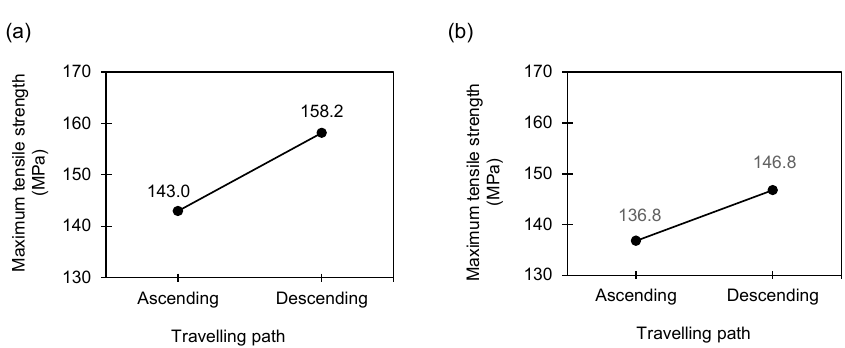
Figure 7. Main effect plots of maximum tensile strength in terms of the travelling paths for experiment ( a ) #3-1 (laser power: 2 kW, part-to-part gap: 0.3 mm) and ( b ) #3-2 (laser power: 4, 4.5, 5.5, and 6 kW, part-to-part gap: 0.3 mm). Table 16. ANOVA table of the tensile strength for experiment #3 ‐ 2 (6.6 ‐ kW disk laser welding system). Table 15. ANOVA table of the tensile strength for experiment #3-1 (2-kW fiber laser welding system). Source Degree of Freedom Sum of Squares Mean Square F -Ratio p -Value Travelling path